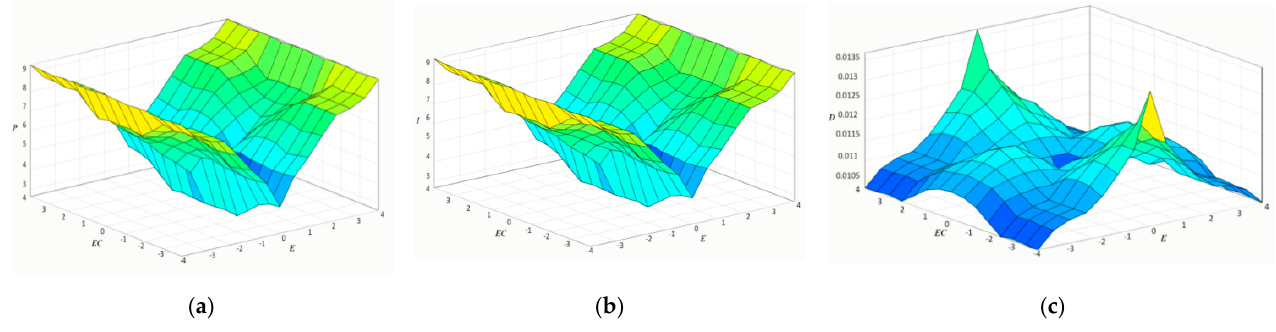
Figure 5. Fuzzy inference variation 3D diagram: ( a ) fuzzy inference U p variation diagram; ( b ) fuzzy inference U i variation diagram; and ( c ) fuzzy inference U d variation diagram.